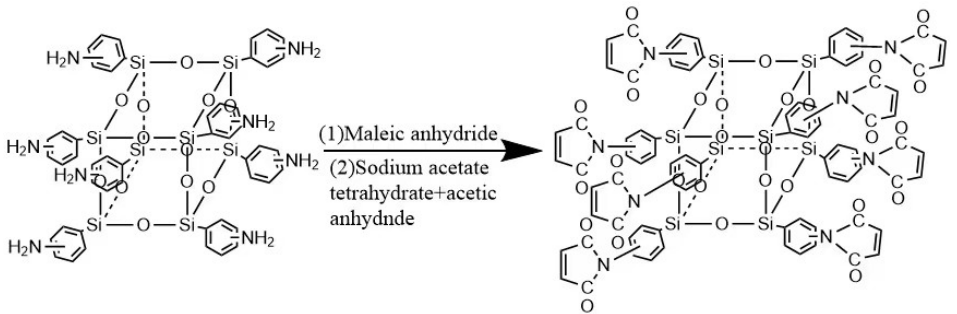
Figure 1. The reaction of OMPS.